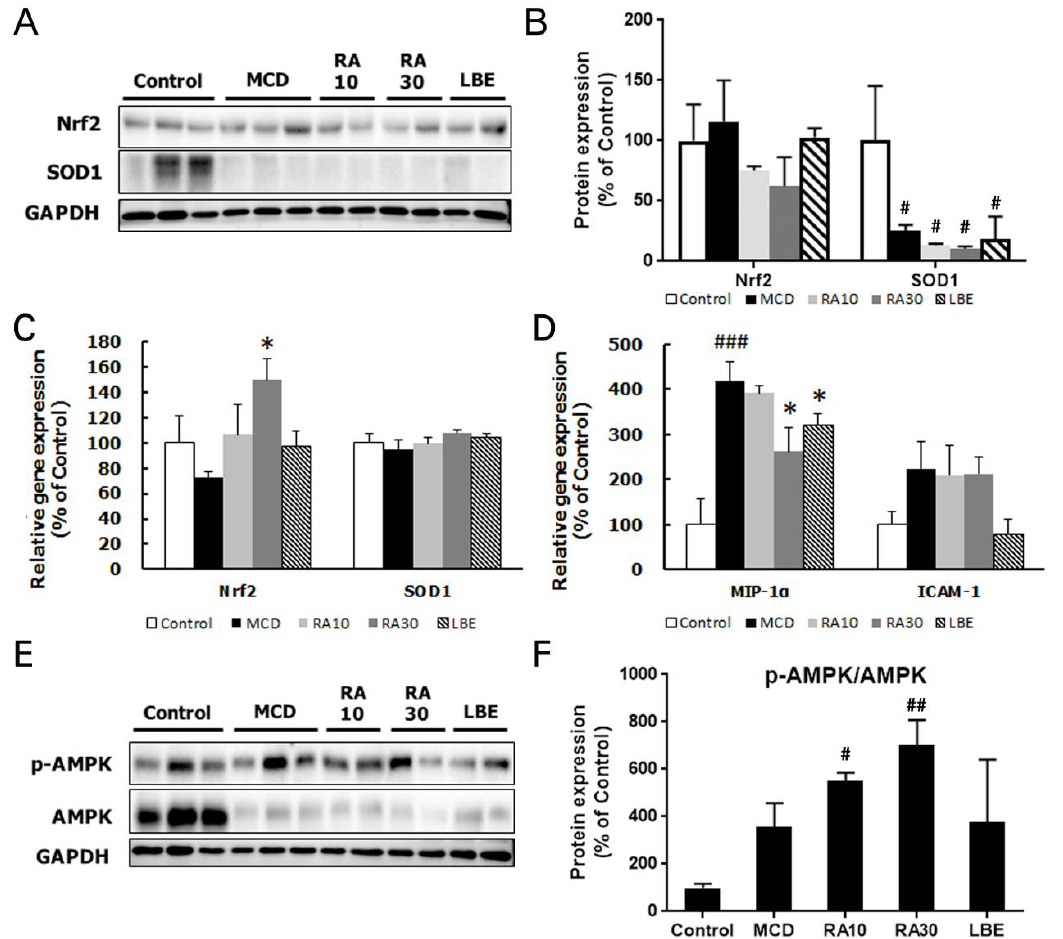
Figure 8. Effects of LBE and RA on the expression of oxidative stress-regulating genes in MCD diet-fed db/db mice. ( A ) Hepatic protein, ( B ) the densitometric analysis of WB, and ( C ) mRNA expression of NRF2 and SOD1. ( D ) Hepatic mRNA expression of macrophage inflammatory protein-1 alpha ( MIP-1 ɑ ) and intercellular adhesion molecule 1 ( ICAM-1 ). ( E ) Phosphorylation of AMPK and ( F ) the densitometric analysis of WB in MCD diet-fed mice treated with LBE or RA. GAPDH was as an internal control for WB analysis and β -Actin was used for mRNA expression. Results are expressed as the mean ± SD (% control). * p < 0.05 compared with the control group; # p < 0.05, ## p < 0.01, and ### p < 0.001 compared with the control group; * p < 0.05 compared with the MCD diet-fed group ( n = 5 – 6 per group).